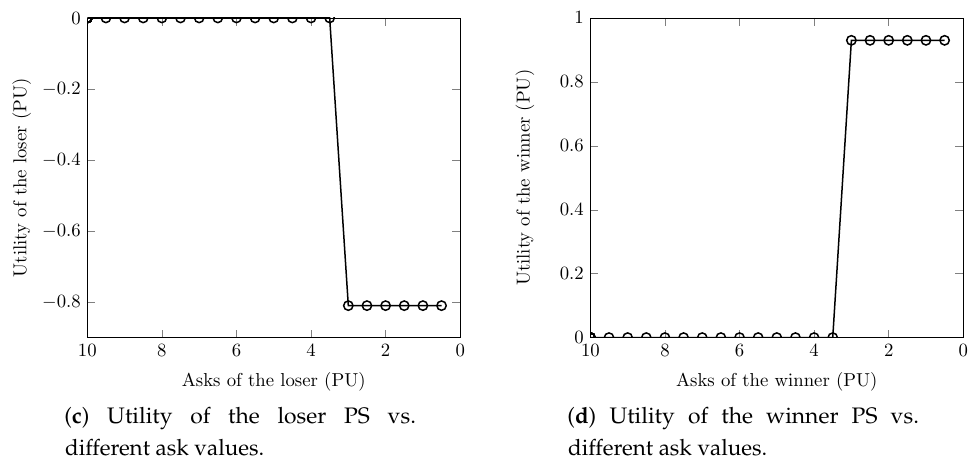
Figure 10. Truthfulness of AERG for the